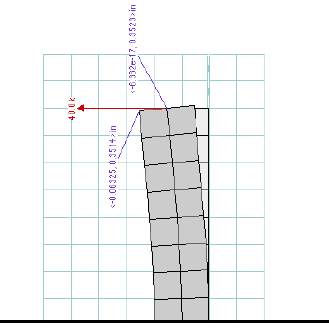
Figure 8. dead constant load of the brick, and bucking effect due to